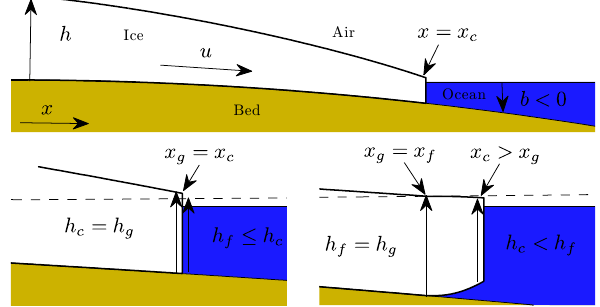
Figure 1. Schematic of the model domain and variables used. Not shown is the lateral dimension: the glacier occupies a channel of width w , potentially variable along the glacier flowline. The upper ice surface shown is at an elevation s = ( 1 − ( 1 − θ)ρ i /ρ w )h + θb , and the lower surface at l = s − h . The lower two diagrams are en- largements of the vicinity of a grounded terminus (left) and a float- ing terminus (right), illustrating the meaning of calving front posi- tion x c , grounding line position x g , calving front height h c , ground- ing line thickness h g and flotation thickness h f . The dashed line indicates where the upper ice surface would need to be at a given position x in order for the ice to be just about to